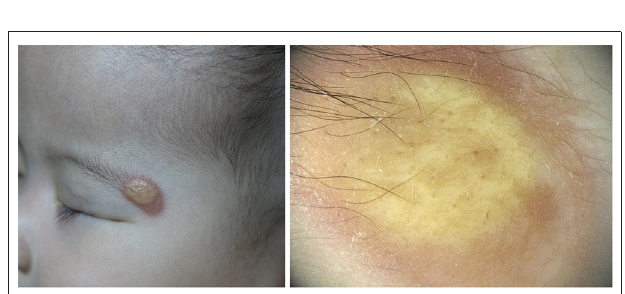
FIGURE 5 | Haloed pigment around the xanthomatous lesion, showing the pigmentation in a peripheral pattern compared with Figure 4